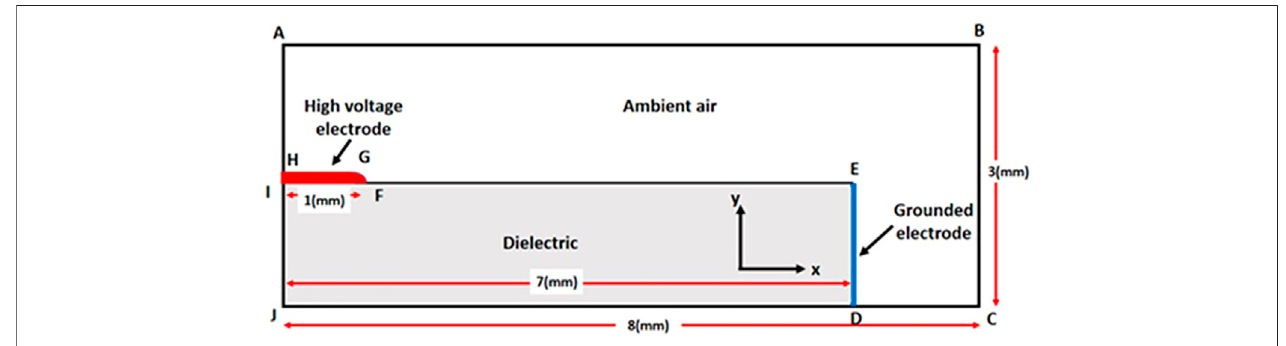
FIGURE 1 | Two-dimensional model used for